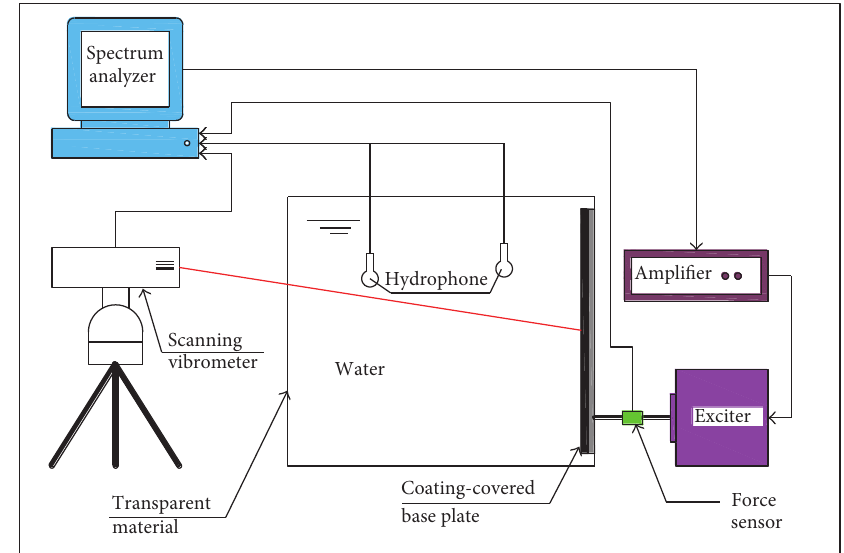
Figure 6: Schematic of the experimental test system.